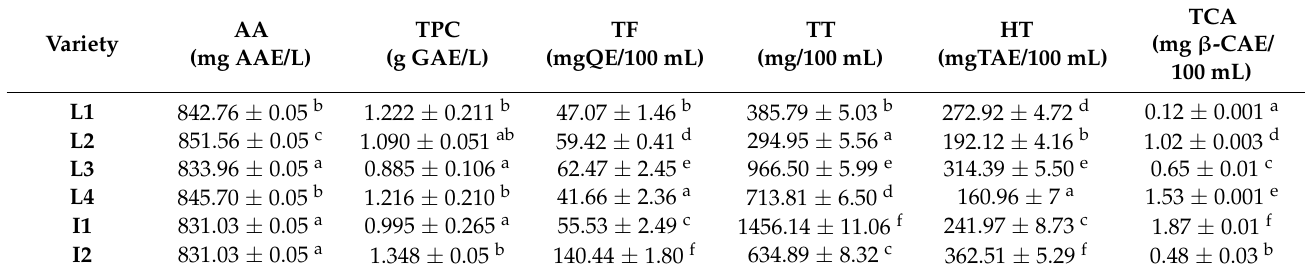
Table 5. Vitamin C, phenolic compounds, and total carotenoids contents of PJ varieties.